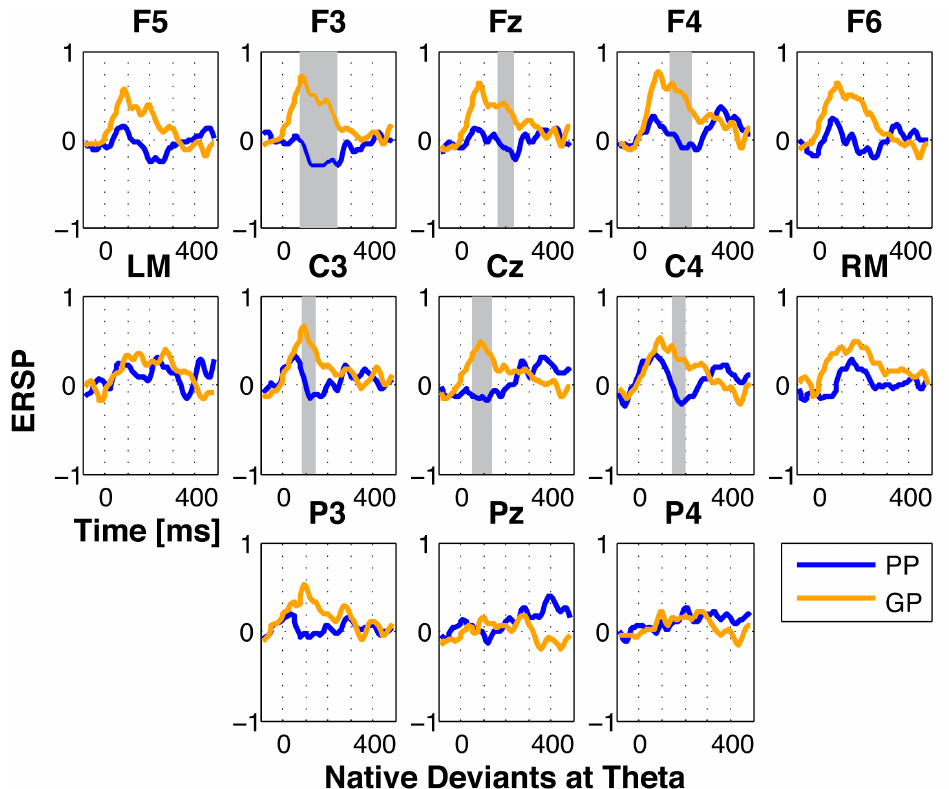
Figure 1. ERSP for the theta band time-locked to the onset of the native deviant phoneme. The grey bars depict the time windows where t-tests yielded significant differences (i.e., p , 0.05 at least for eight consecutive data points) between the two groups (F3 (74–246 ms), F4 (134– 228 ms), Fz (168–236 ms), C3 (90–150 ms), C4 (142–202 ms), and Cz (56–152 ms)).